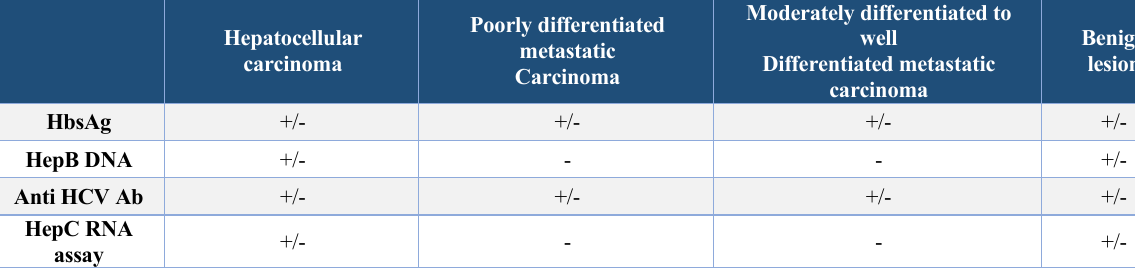
Table 4. Viral marker correlation with the liver cancer